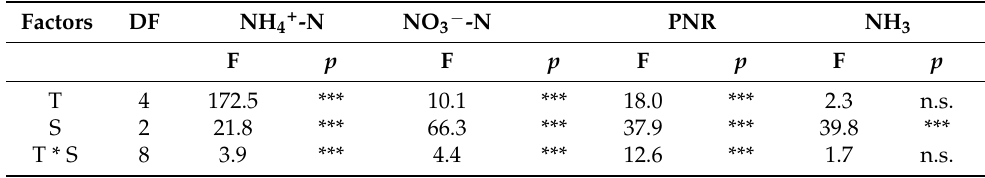
Table 2. Two-way ANOVA ( p < 0.05) examining the effect of different treatments (T), soils with different pH vales (S), and their interaction (T * S) on NH 4+ -N, NO 3 − -N, potential nitrification rate (PNR), and ammonia volatilization (NH 3 ) during the